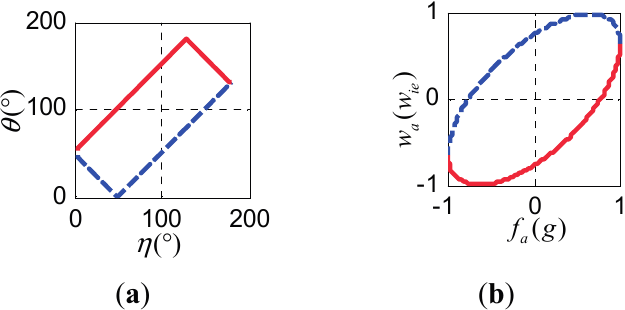
Figure 5. ( a ) The range of θ as a function of η , where the point ( ) ηθ , must be within the rectangle; ( b ) The range of w within the